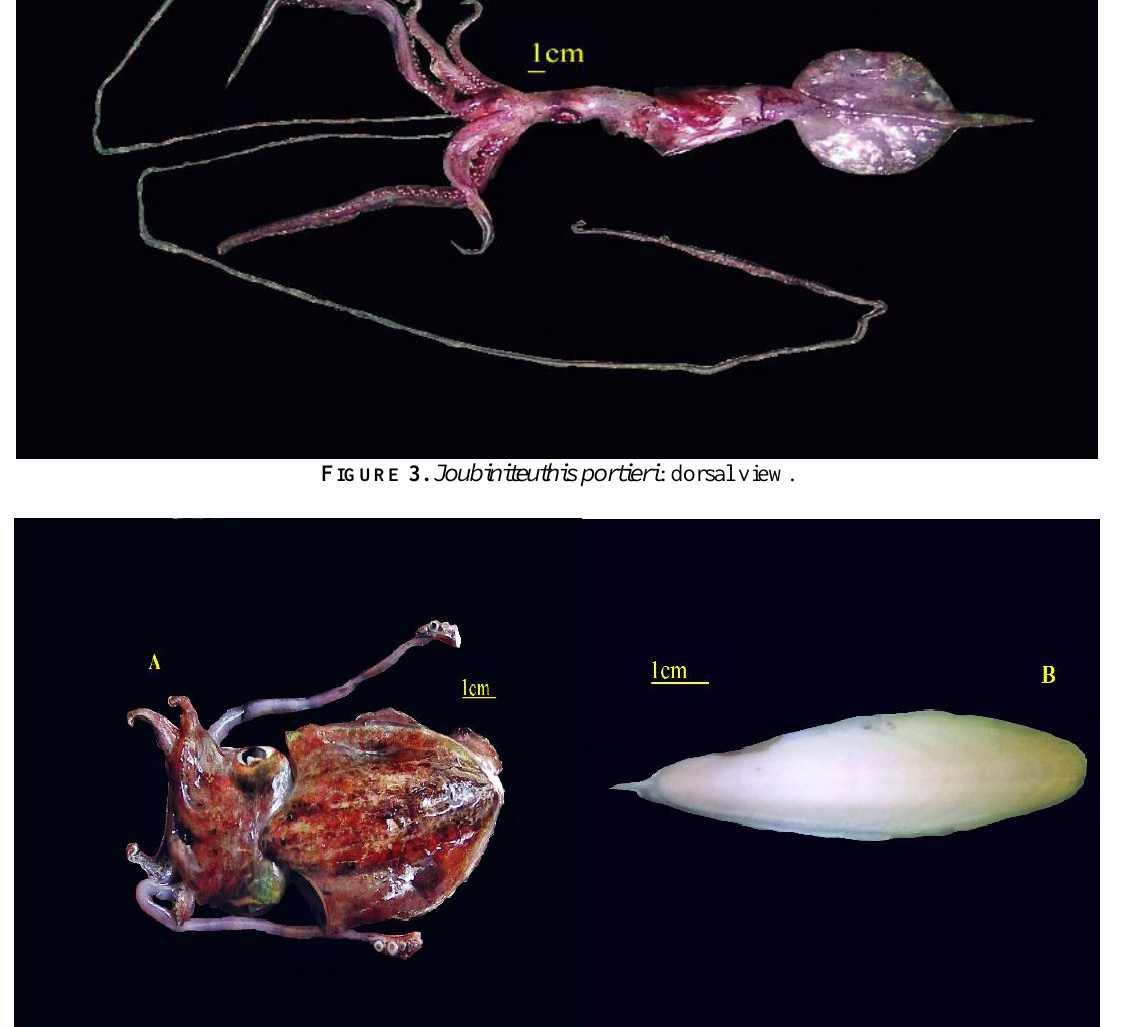
F IGURE 4. Sepia omani : A) dorsal view; B) dorsal view of